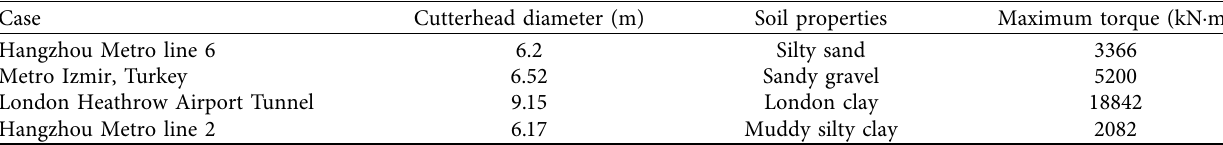
Table 4: Maximum torque values of different